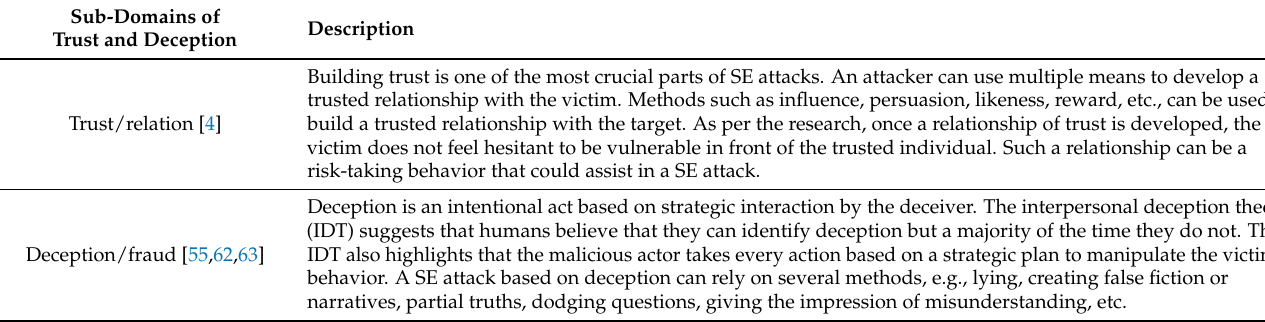
Table 6. Sub-domains of trust and deception to conducting social engineering